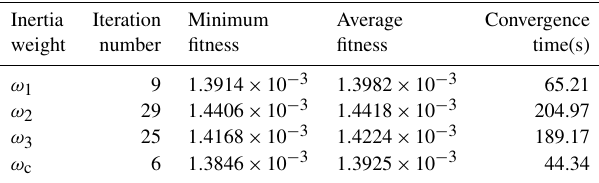
Table 2. Comparison of different inertia weights in PSO algorithms ( ω s = 0 . 9 and ω e = 0 . 4).